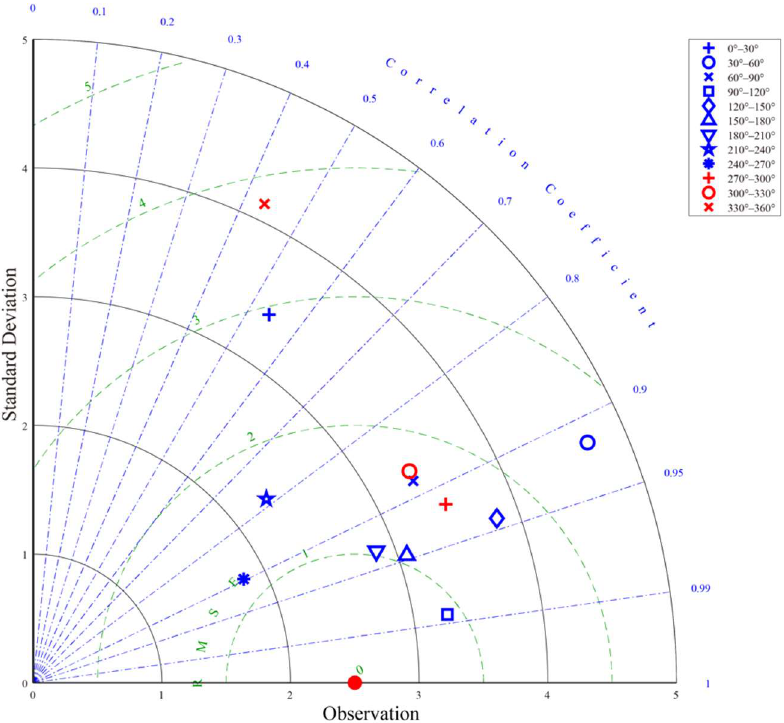
Figure 4. Taylor diagram of the matchups between VH-polarized SAR-derived wind speeds and SFMR observation.